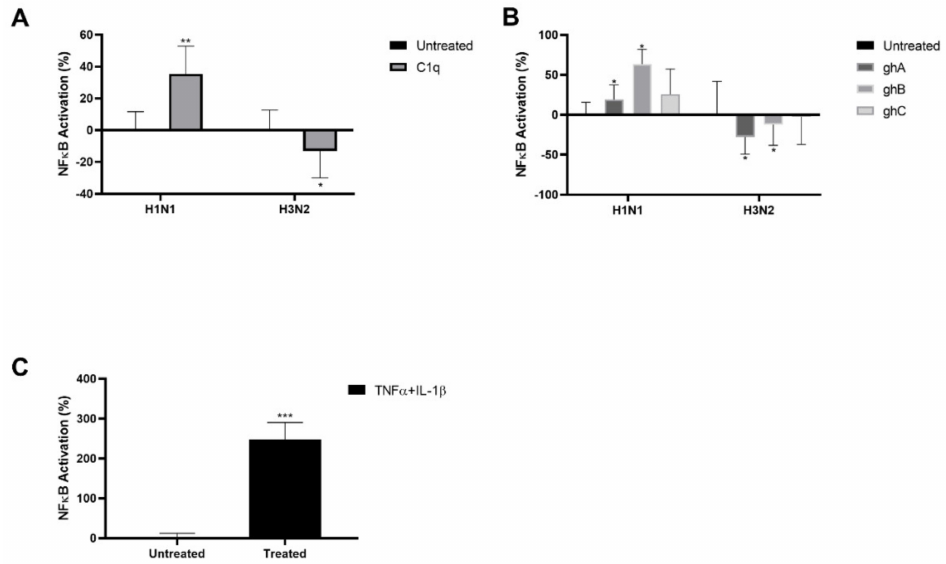
Figure 6. C1q treatment triggers NF- κ B activation during H1N1 infection. NF– κ B activation